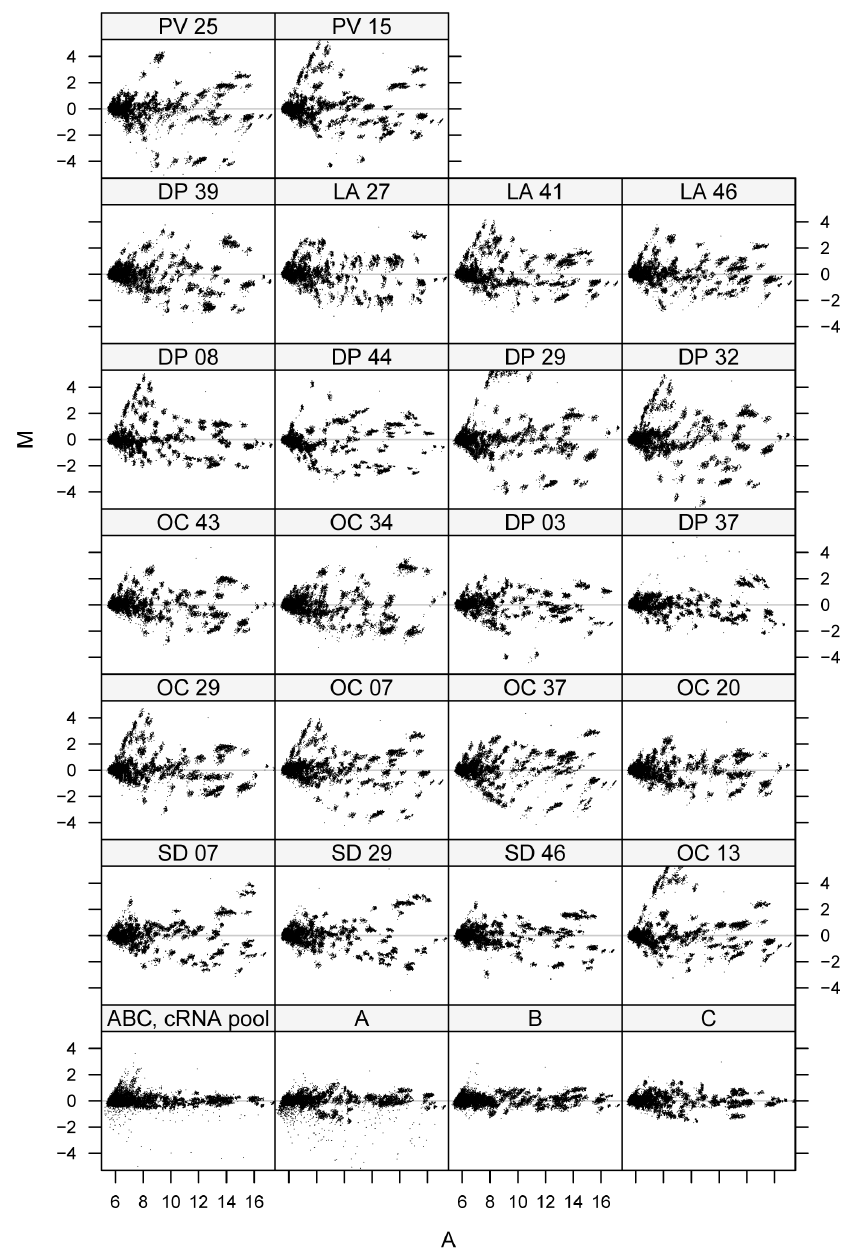
Figure 2. Differential expression and signal intensity measurements for impacted turbot livers. A: Gene expression changes were investigated in male turbot liver collected from exposed fish sampled from sanitation districts in San Diego, Orange County, Dana Point, Los Angeles City and Los Angeles County in California that are considered impacted. Control fish were obtained from a separate monitoring station in Dana Point, a relatively non-impacted area and maintained in a clean-water laboratory for four weeks. The control reference sample consisted of a pool of labeled cRNA from three control fish, designated A , B , and C . M (Y-axis) is a measure of differential gene expression (log2 (exposed /control) in the samples in the first three panel rows of plots or absence of significant differential gene expression in the self-self plots (log (control / control intensity) in the bottom panel row of 2 plots. A (X-axis) is a measure of signal intensity (0.5 log exposed intensity + 0.5 log control intensity) in the first three panel rows of 2 2 plots or (0.5 log control intensity + 0.5 log control intensity) in the bottom panel row of plots. Careful analysis of the heavy tail of 2 2 outliers for the individual fish A (second panel from right, bottom row), revealed these data points in the tail are not real and are derived from an array artifact. doi: 10.1371/journal.pone.0075553.g002 PLOS ONE |